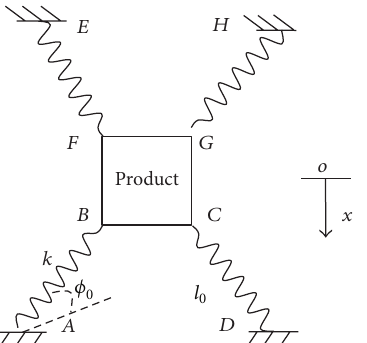
Figure 1: Dynamic model of the suspension spring system.